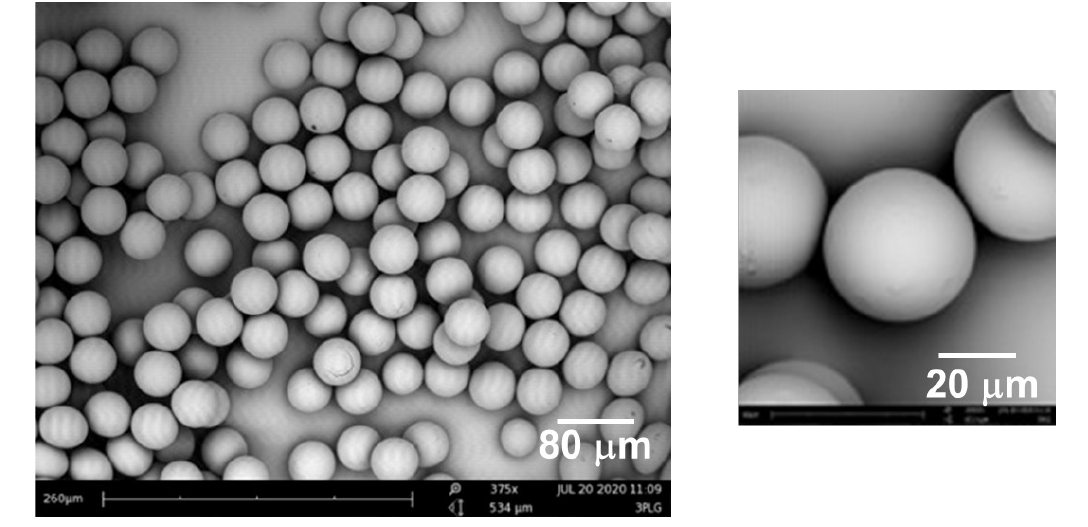
Figure 16. High resolution SEM image of PLGA microspheres prepared by microfluidic emulsification. Monodispersed microspheres of 40 μm diameter.